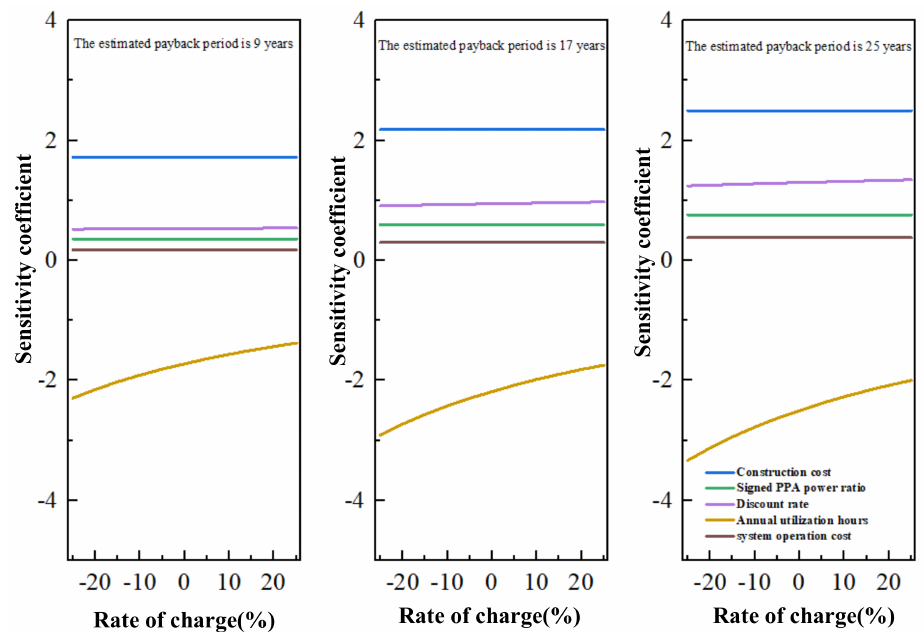
Figure 6. Sensitivity analysis of investment payback periods for different contract electricity